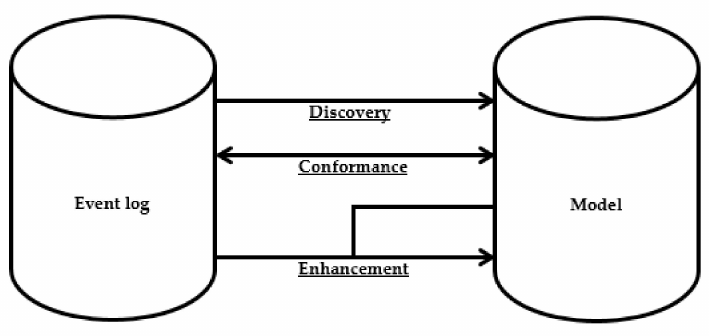
Figure 1. Process mining